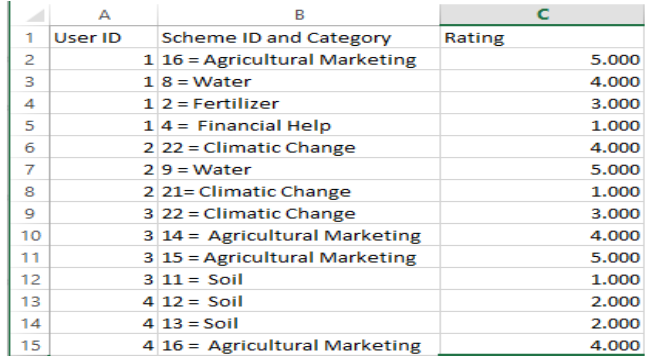
Figure 5. Count Of